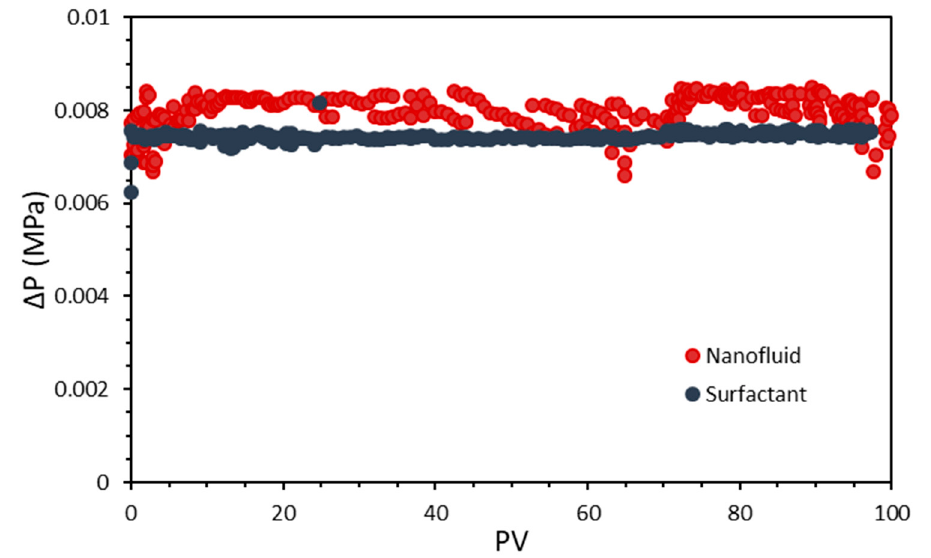
Figure 15. Injectivity tests carried out for the surfactant and nanofluid formulations under reservoir conditions (50 °C, and 9.31 and 3.45 MPa of overburden and back pressure, respectively). For the surfactant injection, the Core 1 reported in Table 2 was used, while the Core 2 was implemented for the nanofluid injection.